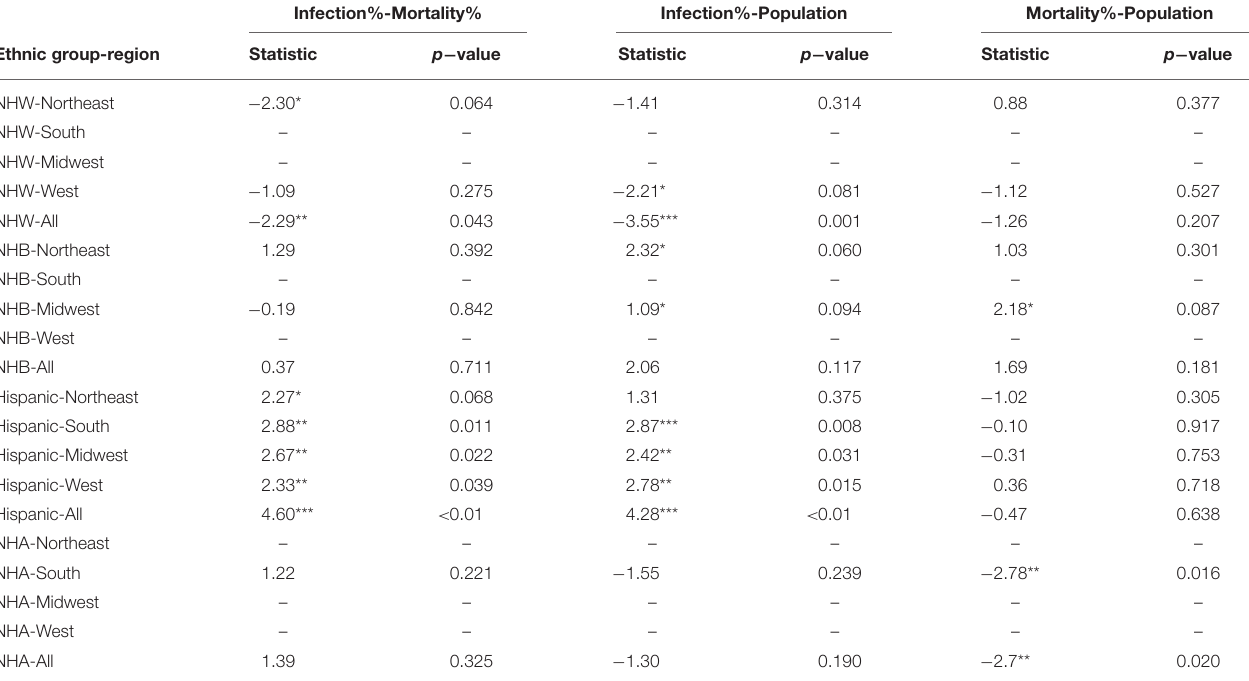
TABLE 2 | Post-hoc analysis using Dunn Test and their significance